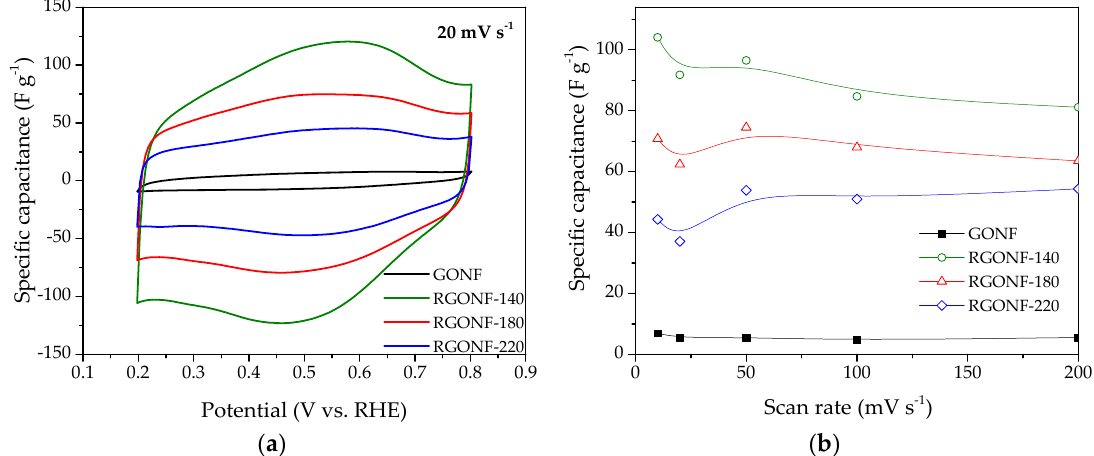
Figure 6. ( a ) Specific capacitance vs. potential curves at 20 mV · s − 1 of GONF and RGONF samples. ( b ) Specific capacitance as a function of the scan rate. Aqueous electrolyte: 0.5 M H 2 SO 4 . ◦ − 1 The samples reduced at 140, 180, and 220 C present capacitance values up to 104, 75, and 55 F · g , respectively. RGONFs present fishbone arrangement (from the original CNFs) with